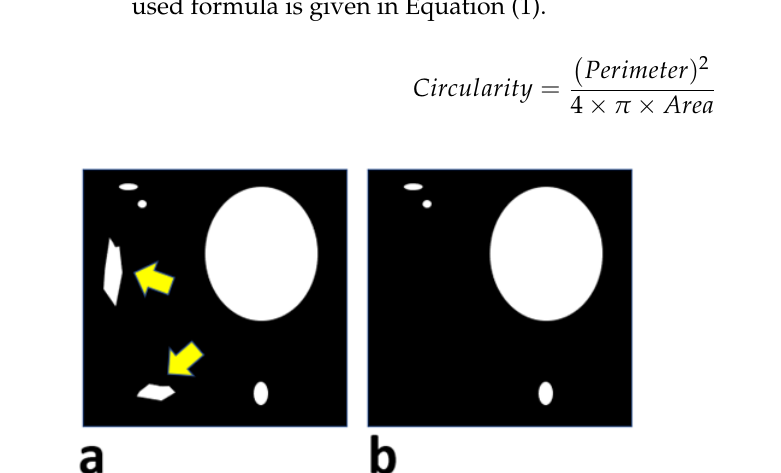
Figure 5. Schematic that shows elimination of the irregular shaped regions by using circularity as a threshold where, the irregular shaped artifacts as seen in ( a ) (indicated by arrows) are removed which results in the inclusion with only minor artifacts as seen in ( b ).